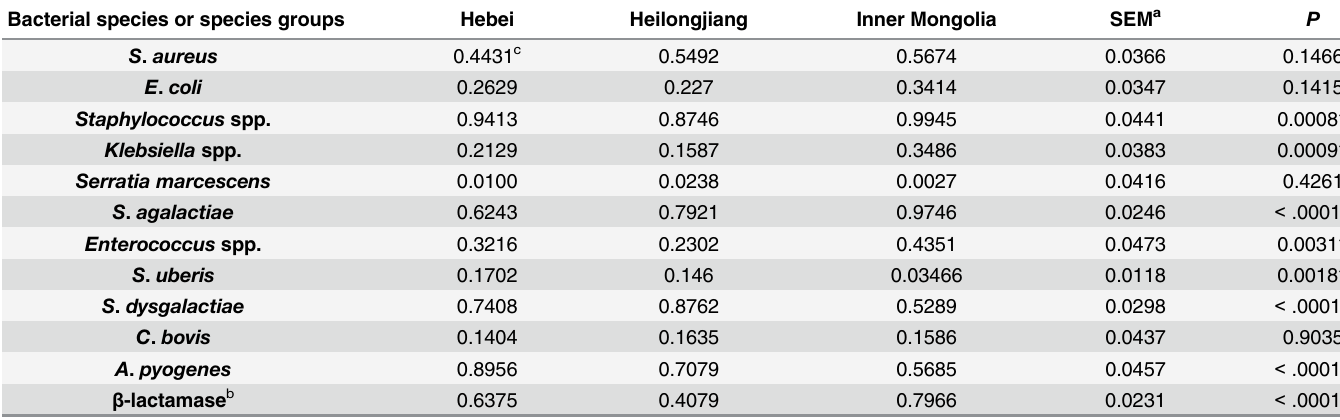
Table 4. Effect of regions on the presence of mastitis pathogens. Bacterial species or species